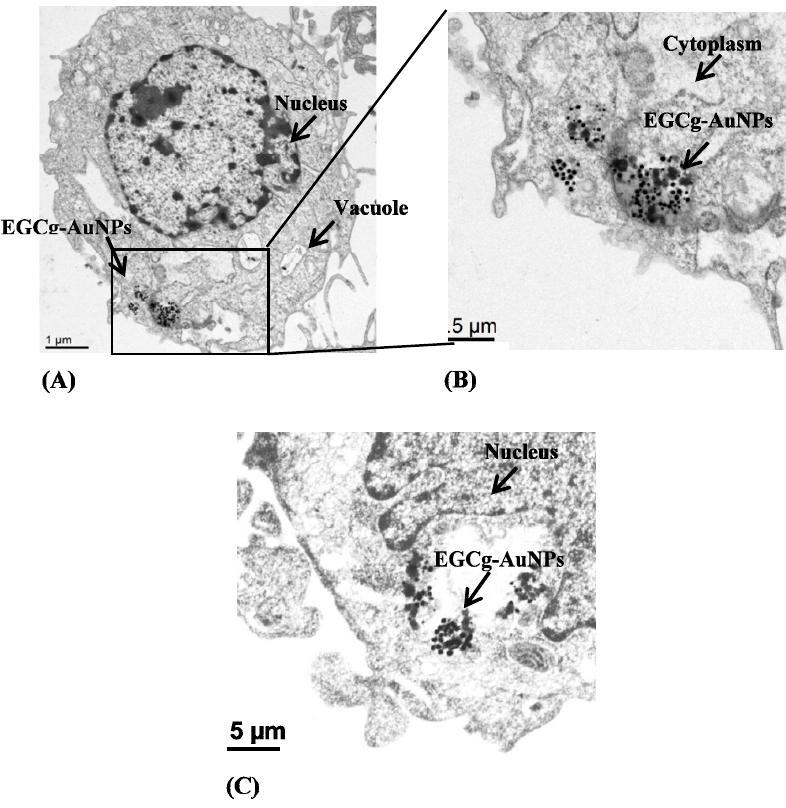
Figure 3. Cellular internalization of EGCg gold nanoparticles in HUVECs ( A , B ) and HCASMCs ( C ) with concentration 20 µ g/mL, 2 h; images were captured by transmission electron microscopy. HUVECs (Human umbilical vein endothelial cells); HCASMCs (Human coronary artery smooth muscle cells).